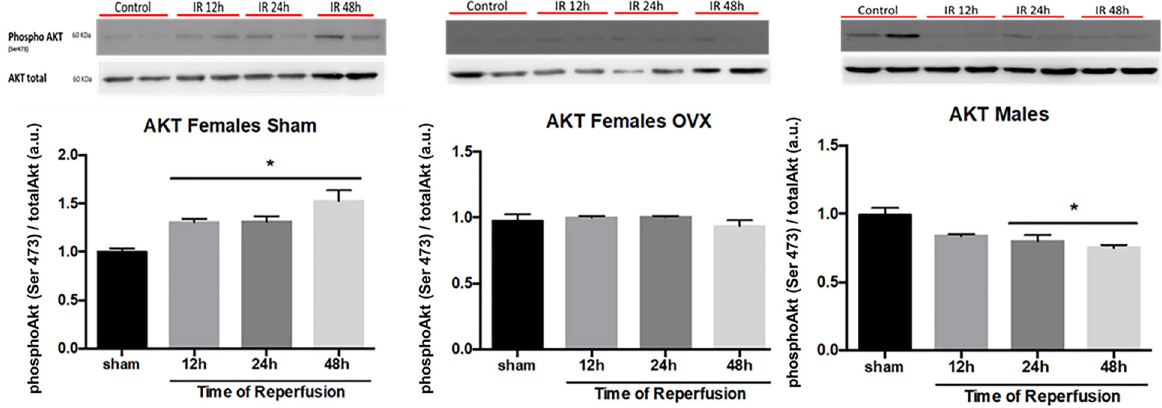
Figure 4. Akt protein analysis at different times after reperfusion among female sham and female OVX mice, and male mice. Data are reported as means ± SE. *P o 0.05 vs sham (ANOVA). OVX: bilateral ovariectomy; a.u.: arbitrary